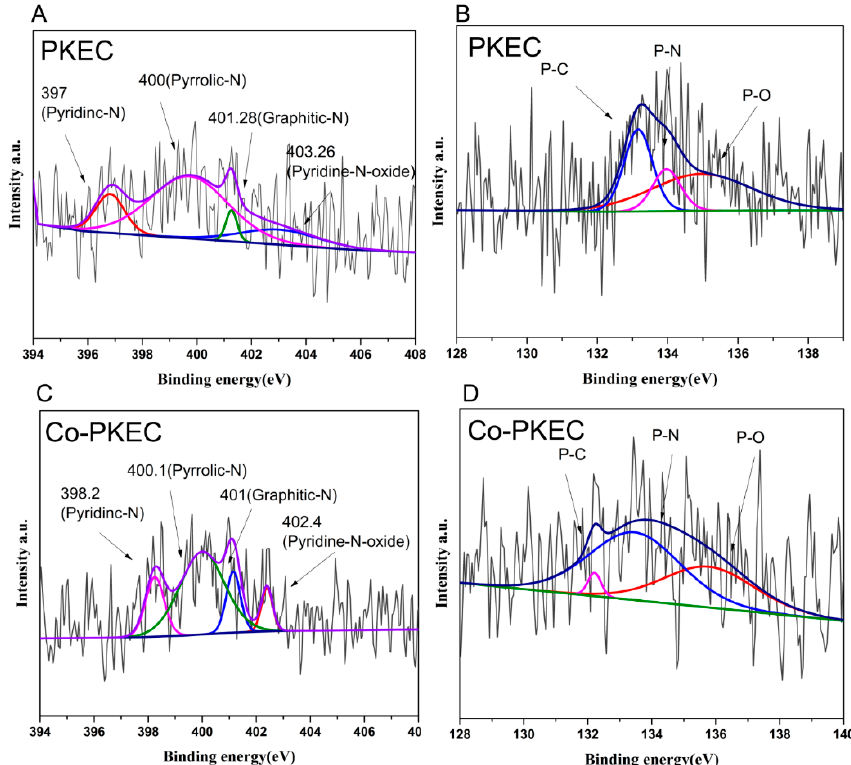
Figure 8. N 1 s ( A , C ) and P 2p ( B , D ) XPS spectra of PKEC and Co-PKEC.